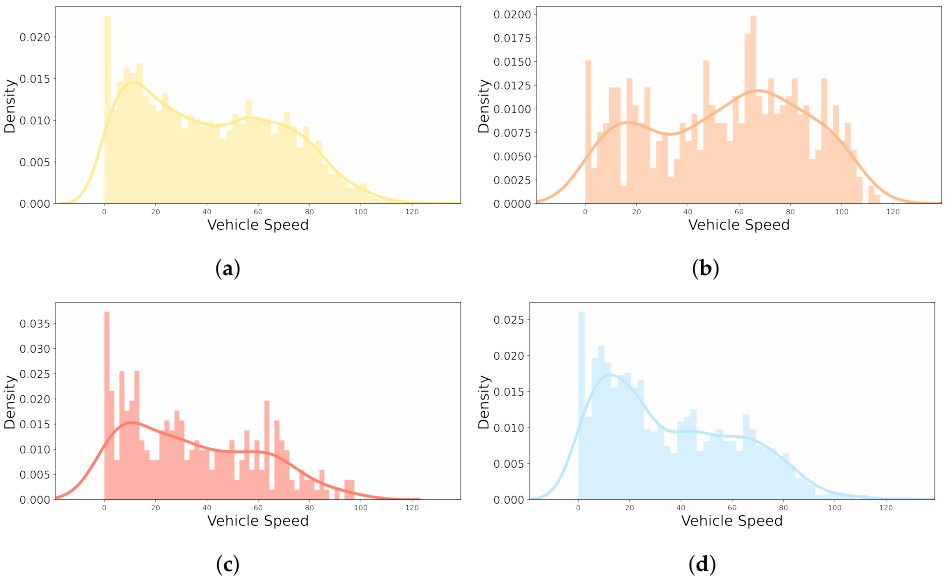
Figure 7. Distribution of vehicle speed by self-reported emotion labels in real-world driving.